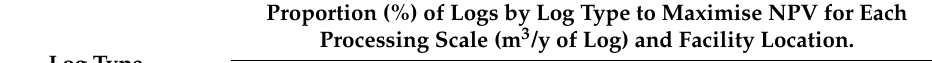
Table 6. Optimal proportion of log types in log procurement scenario 3 by processing scale and facility